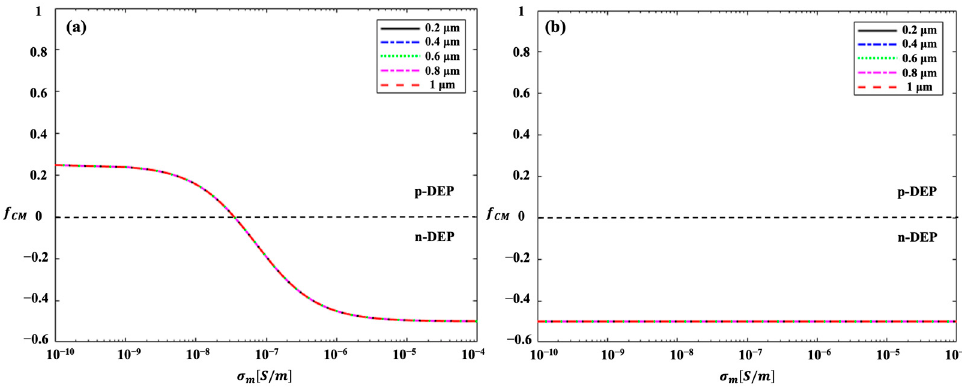
Figure 7. The CM factor of 3-micrometer Chlorella coated with ( a ) 50% and ( b ) 100% PS particles coverage but with various different PS-particle-coating thicknesses, i.e., diameters of PS particles of 0.2 µ m, 0.4 µ m, 0.6 µ m, 0.8 µ m, and 1 µ m, varying with the electrical conductivity of the surrounding